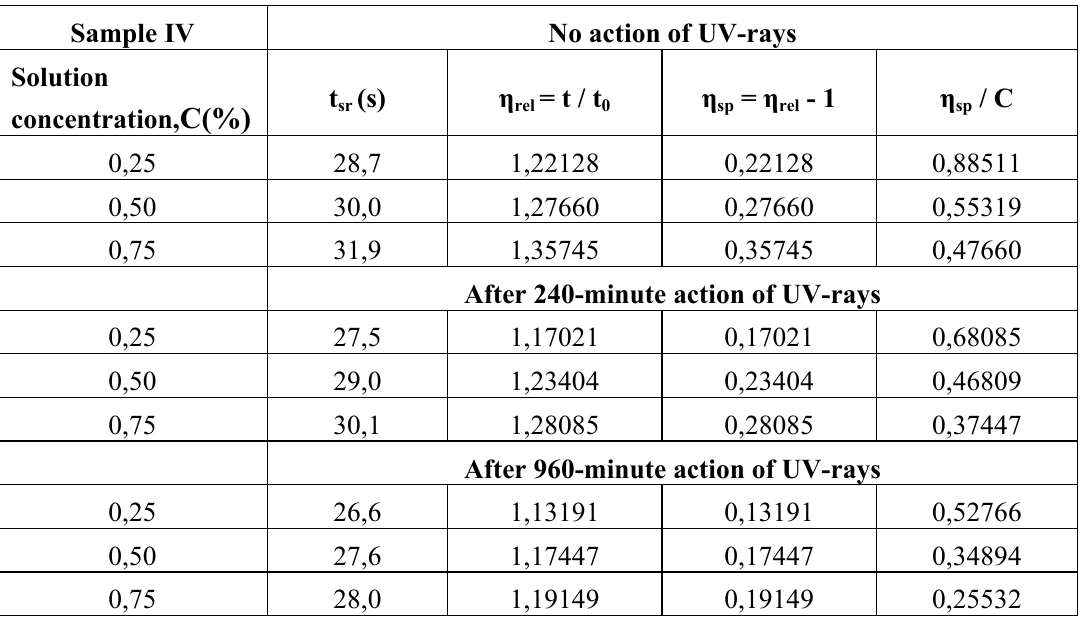
Table 7. Viscosity values of nitrodope solution in acetone for sample IV Sample